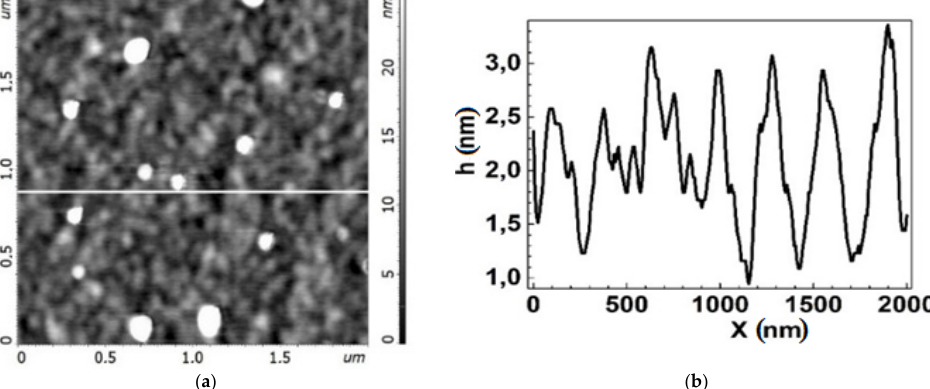
Figure 5. Topography of the graphene surface for chip EG335-5 from Group 1 before the functionalization process: ( a ) AFM image of the surface with less bright areas than in Figure 4a. ( b ) AFM profile of the graphene surface along the white line in Figure 5a, showing the characteristic arrangement of the nanomaterial of the surface. Bright areas are equivalent to peaks with large magnitude on the profile curve.